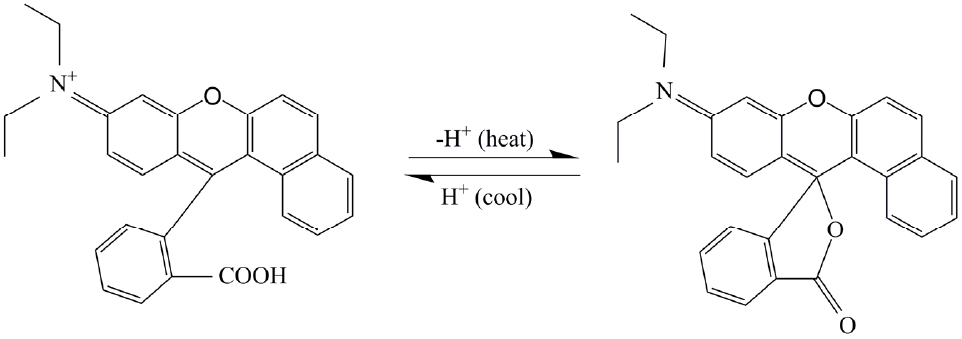
Figure 10. Thermochromic mechanism of fluorane thermochromic microcapsules.